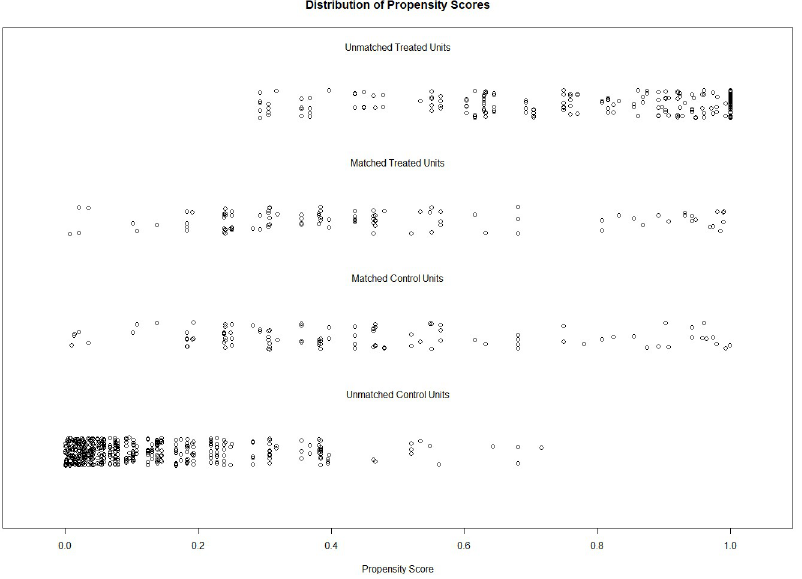
Fig 4. Propensity score distribution in Analysis 1a for the overlap between the 2002 sample and the 2020 sample. Unmatched units were discarded after the matching procedure to ensure an optimal overlap in propensity scores of the two